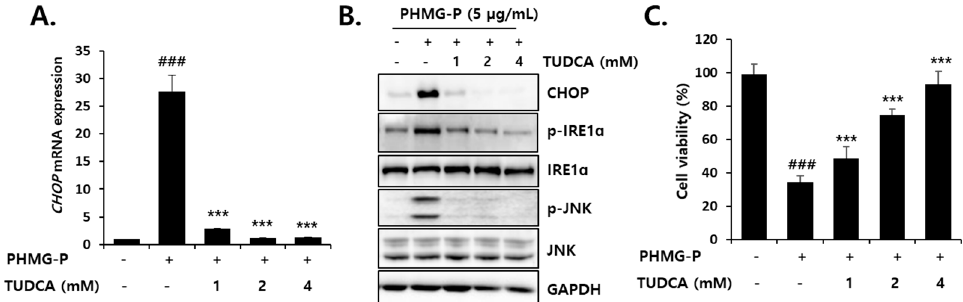
Figure 6. The preventive effect of ER stress inhibitor, TUDCA, on PHMG-P-induced cytotoxicity in HepG2 cells. The cells were pretreated with TUDCA for 2 h and then treated with 5 µg/mL PHMG-P for 24 h. The expression of ( A ) CHOP mRNA and ( B ) ER stress-related proteins were determined using real-time PCR and western blotting, respectively. ( C ) The MTT assays were performed to measure cell viability. The cell viability (%) was expressed as a percentage of the viability of untreated cells. Each value represents the mean ± SD of triplicate experiments. (### p < 0.001, significant versus vehicle-treated; *** p < 0.001, significant versus PHMG alone).